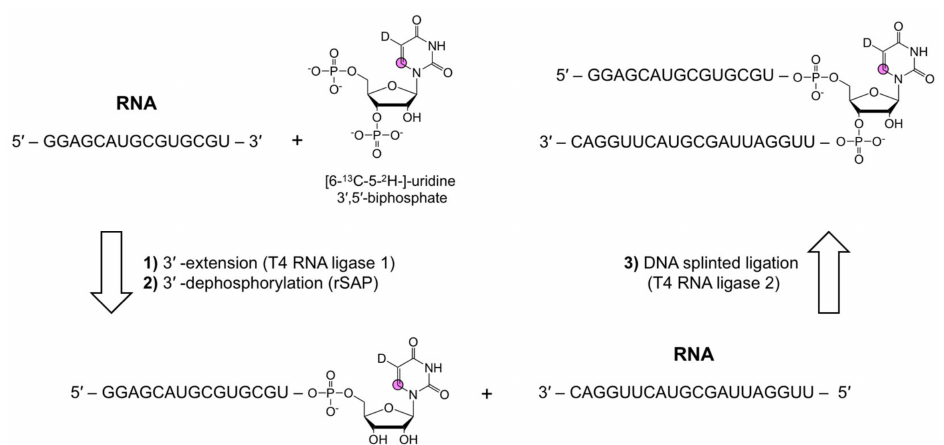
Figure 7. A position-specific RNA labeling strategy adapted from Schwalbe and co-workers [116]. Labeling is achieved via 3 (cid:48) -end extension with a modified 3 (cid:48) ,5 (cid:48) -biphsophate nucleoside, followed by 3 (cid:48) -end dephosphorylation of the nucleoside by T4 RNA ligase 1 and rSAP. Lastly, DNA splinted ligation with T4 RNA ligase 1 combines the modified RNA with a 5 (cid:48) -phoshporylated donor RNA. Additional details can be found in the original work